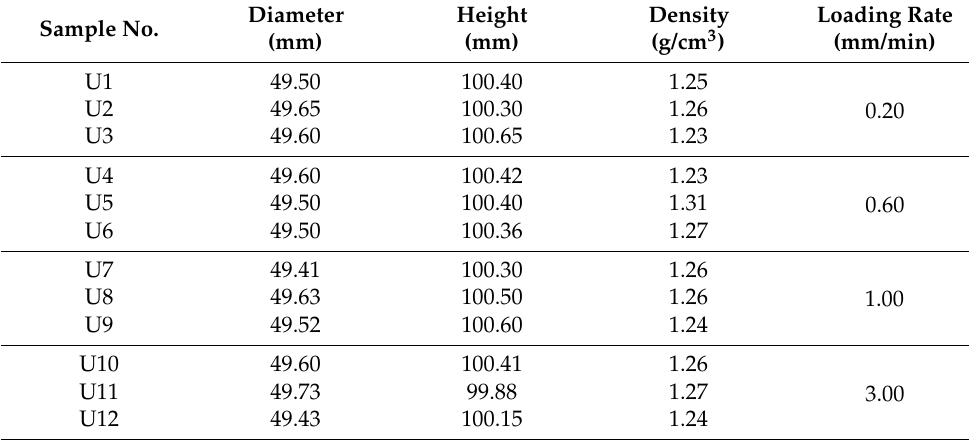
Figure 1. Location of Hongqinghe Coal Mine. Table 1. Physical properties of coal